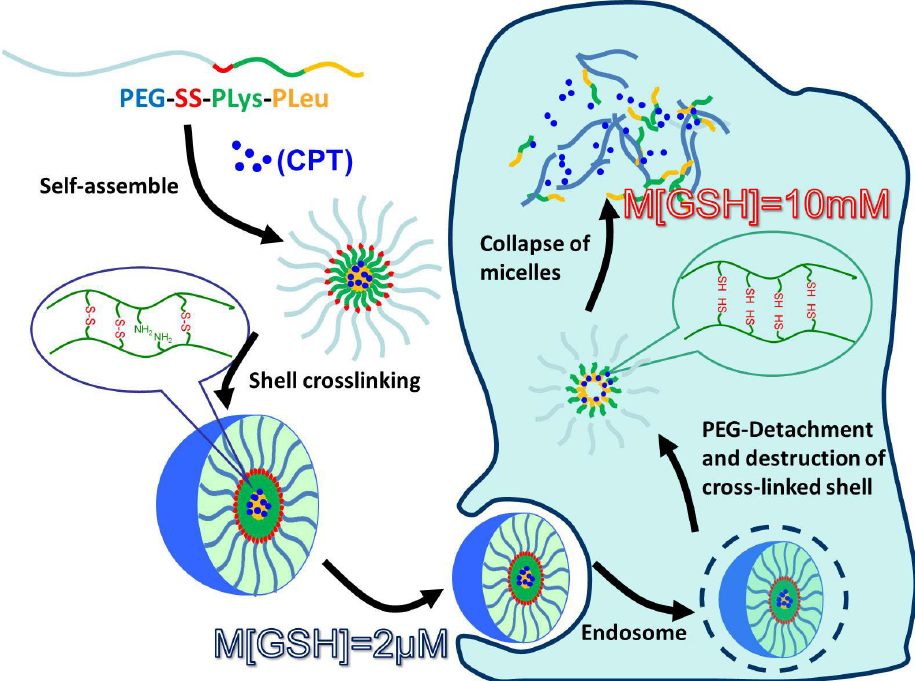
Figure 7. Schematic illustration of the GSH-trigged DePEGylation and drug release of PEG-SS-PLys- PLeu micelles. Reprinted with permission from Ref. [124]; Royal Society of Chemistry.